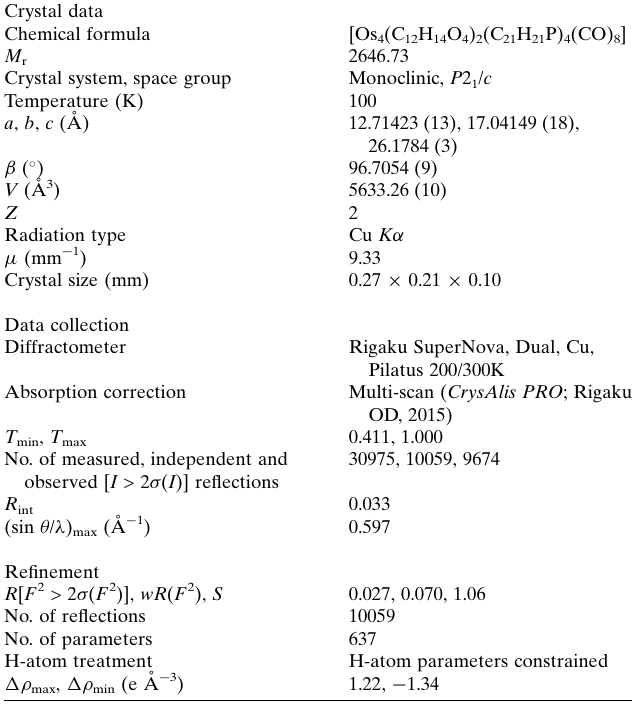
Crystal data Chemical